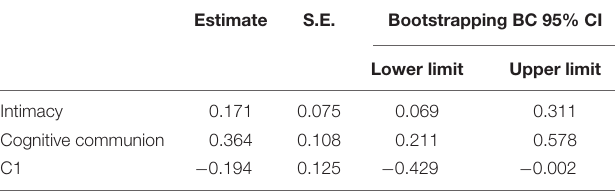
TABLE 8 | Indirect effects of intimacy and cognitive communion on psychological well-being through social integration.